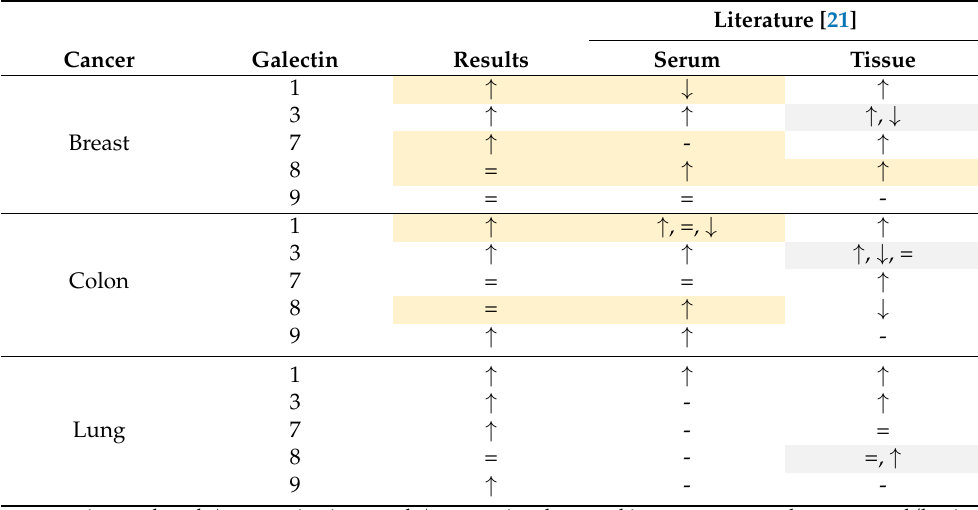
Table 2. Comparison of galectin level changes in cancer